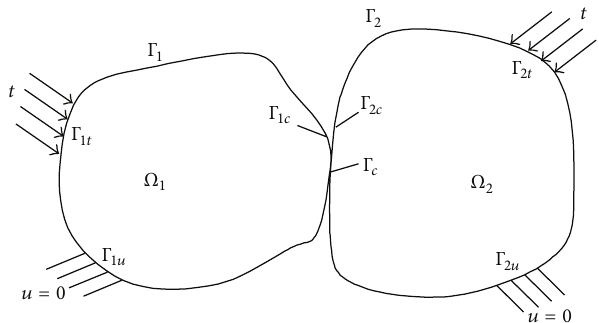
Figure 1: Contact of two deformable bodies.